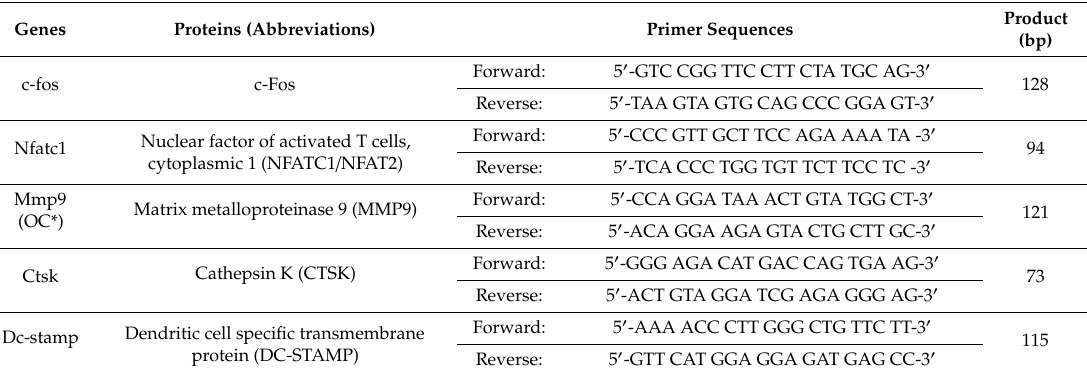
Table 1. Primer sequences for